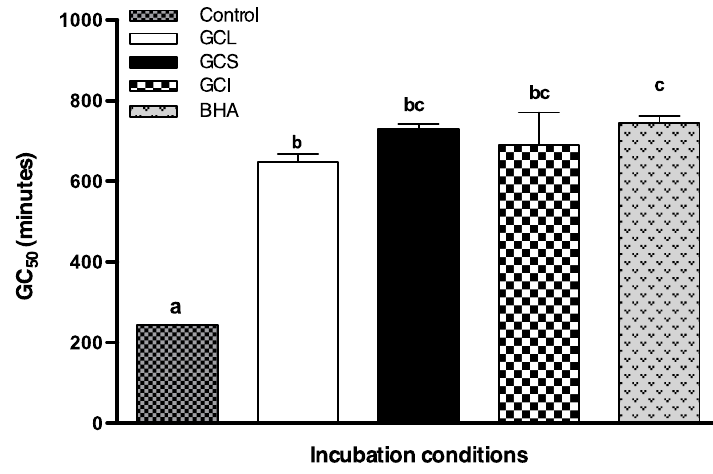
Figure 5. Protective effect of Cc extracts and BHA at 25 μ g·mL − 1 against 0.1 mM H oxidative damage, expressed in terms of GC three determinations. At least one same letter means no significant differences at P ≤